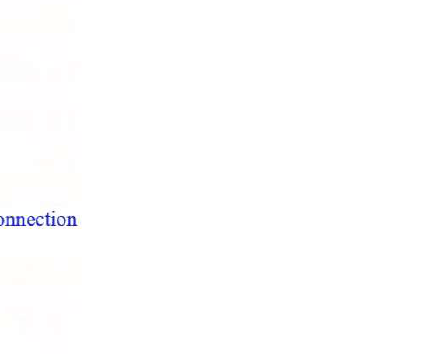
Figure 5. The working principle diagram of suction and drainer device for bearing of wind turbine.